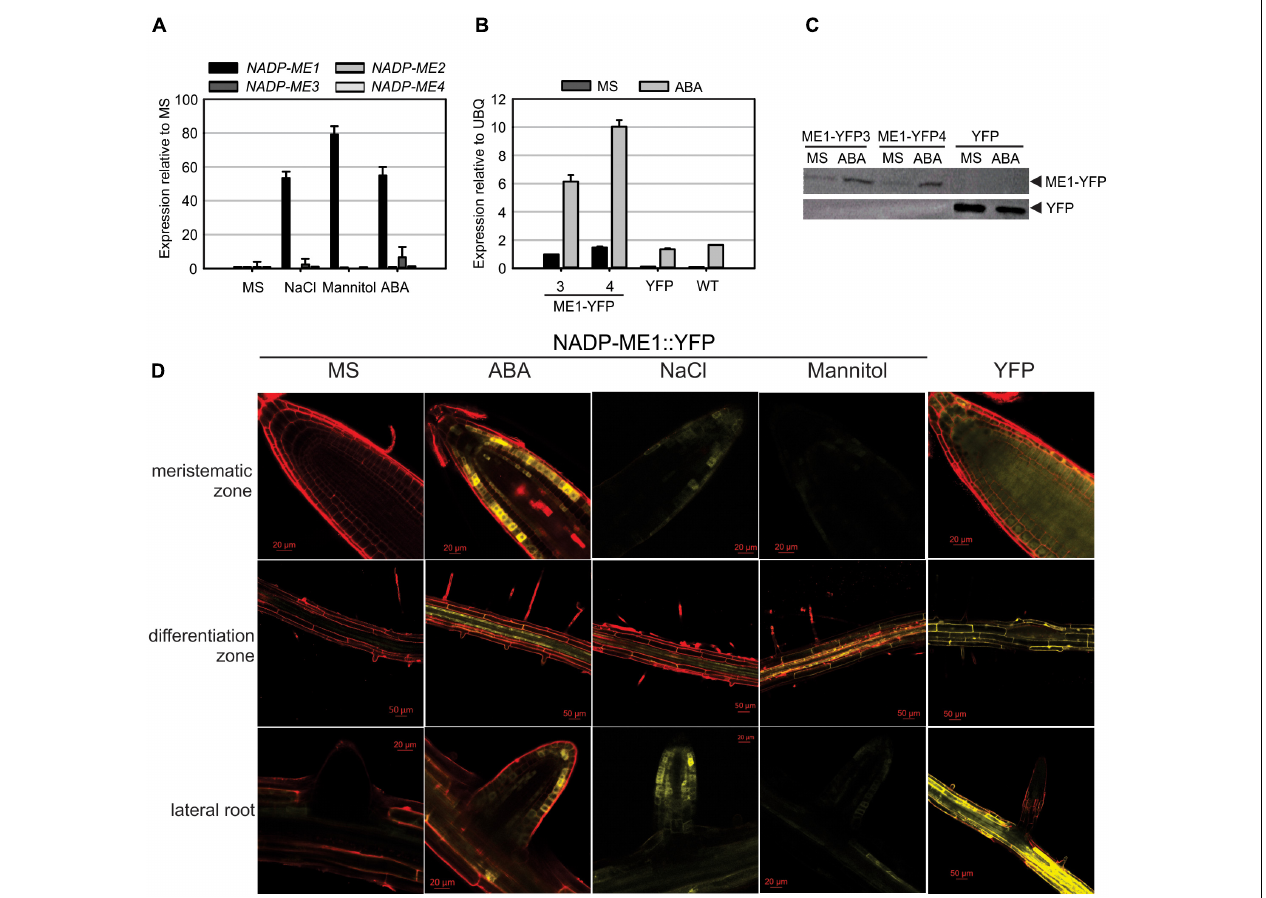
FIGURE 2 | NADP-ME1 expression in response to NaCl, mannitol, and ABA. (A) Relative levels of the transcripts of NADP-ME genes in rosettes in control conditions (MS) or after 6 h treatments of seedling with 100 mM NaCl, 225 mM mannitol, or 10 µ M ABA. The polyubiquitin 10 gene (UBQ) was used as reference. (B) Response of NADP-ME1 promoter in transgenic lines. ME1-YFP3 and 4 are two independent transgenic lines expressing NADP-ME1::YFP under the control of NADP-ME1 promoter. YFP denotes a line expressing the YFP coding sequence under the control of the double 35SCaMV promoter. The level of NADP-ME1 was compared in control conditions (MS) and after treatment with 10 µ M ABA during 6 h was applied. The values are the average of three independent experiments ± SD. (C) Western blot of the seedling protein extract (30 µ g) from the transgenic lines. Molecular mass markers were run in parallel and stained with Coomassie Blue to localize the position of fusion and YFP proteins. (D) Expression of the fusion protein NADP-ME1::YFP in roots in response to ABA, NaCl, and mannitol. YFP fluorescence in different parts of roots of 8-day-old seedlings incubated with 10 µ M ABA, 100 mM NaCl, or 225 mM mannitol for 6 h. Scale bars are indicated in each panel. Right panels show the fluorescence distribution of the control YFP line. These results were confirmed in two independent